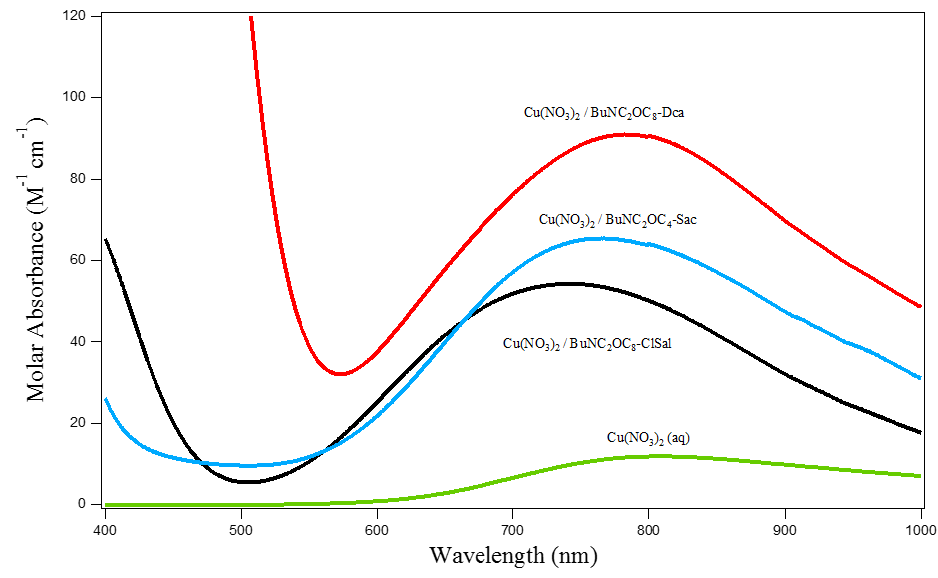
Figure 5. UV-Vis spectra of Cu(NO 3 ) 2 in aqueous and in ionic liquid phase. C metal = 0.05 mol L −1 ; V w = 2 mL; m Il = 0.5 g; UV-vis spectra are recorded in ethylacetate for IL phase.